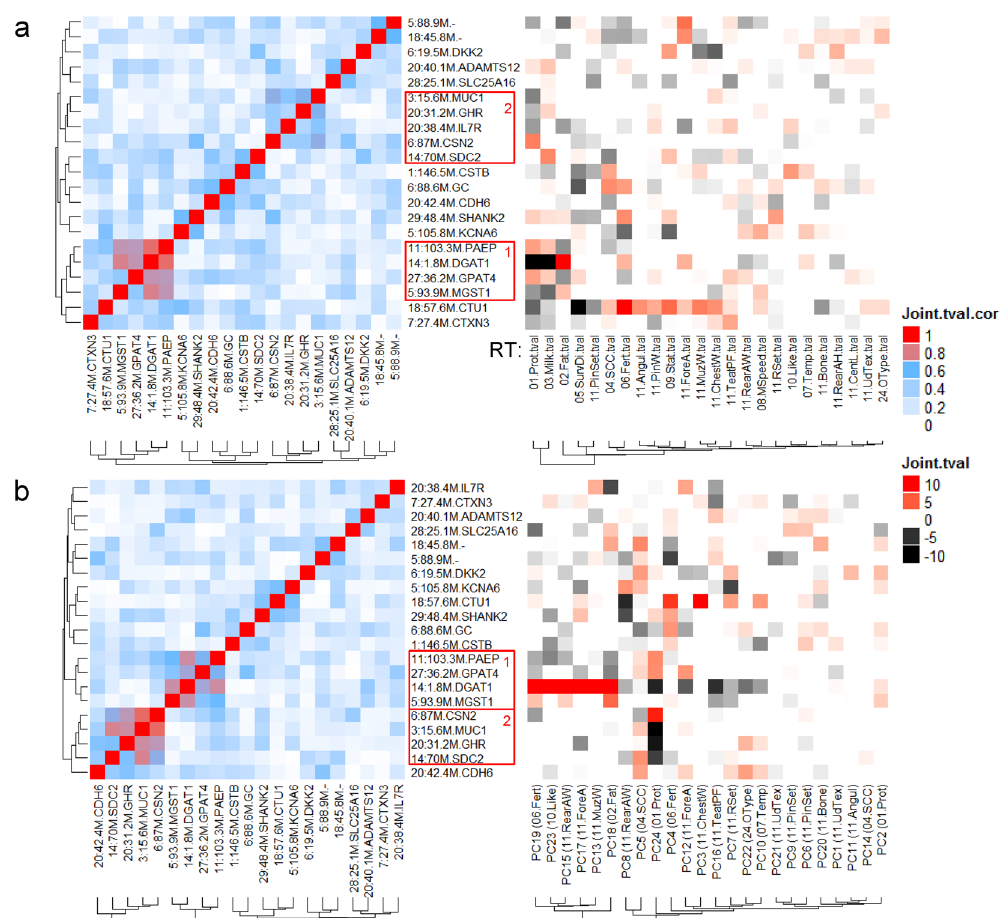
Figure 5. Clustering of lead SNPs representing major loci affecting dairy raw traits (RTs, a ) and principal components (PCs, b ) in the discovery population. Loci displaying similar effect clustering patterns across RT, PC and Choleskey transformed traits (Supplementary Figure S3) were highlighted in red boxes. Loci labels on the Y-axis were the same for both left (correlation of SNPs’ effects) and right (SNP’s effects on traits) panels. t values with absolute values >= 1 and validated for consistent effect directions between the discovery and validation populations were coloured. The RT associated with the top factor loading value of each PC was shown in the parentheses on the right panel (Supplementary Table